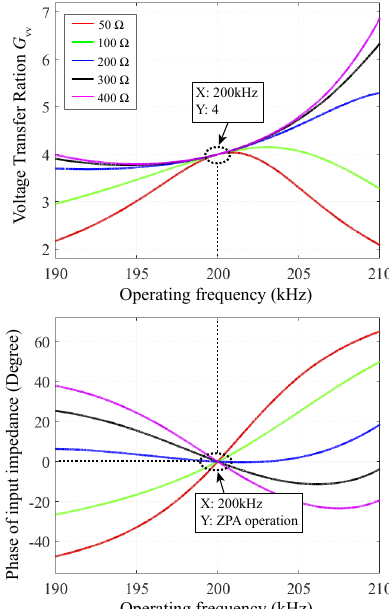
Figure 9. Voltage transfer ratio and input phase angle of the LCC-parallel compensation topology versus the frequency for different load conditions.